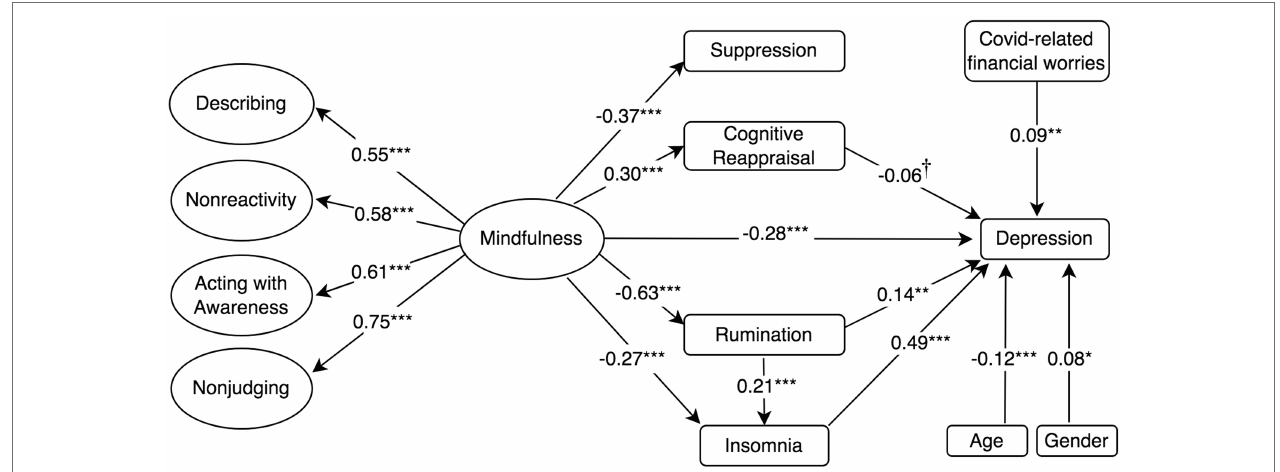
FIGURE 1 | Standardised mediation Model 1 of the effect of higher-order mindfulness on depression. Depression = PHQ-8, 8-item Patient Health Questionnaire; Rumination = RSS-SF, 10-item Rumination Response Scale-Short Form; Cognitive Reappraisal and Suppression = ERQ, 10-item Emotion Regulation Questionnaire; Insomnia = ISI, 7-item Insomnia Severity Index; and Mindfulness and facets = FFMQ-SF, 24-item Five-Facets Mindfulness Questionnaire-Short Form. † p < 0.10; * p < 0.05; ** p < 0.01; and *** p ≤ 0.001.